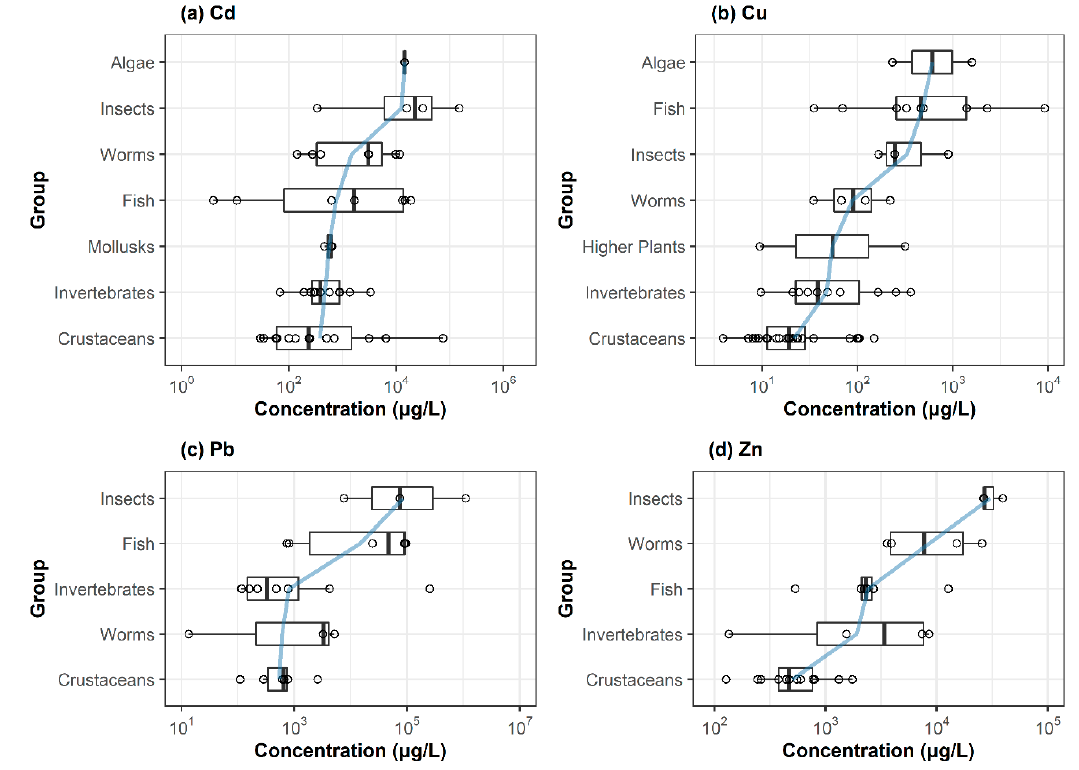
Figure 2. Comparison of acute toxicity for heavy metals including ( a ) Cd, ( b ) Cu, ( c ) Pb, and ( d ) Zn among different taxa .